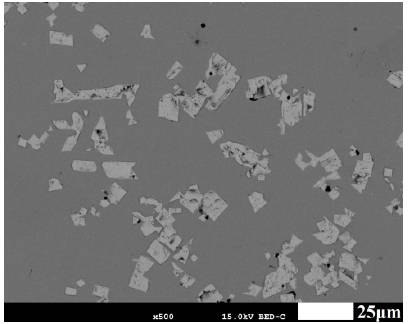
Figure 9. Sample scanning image of alloy with the addition of 4.5% Nb after solution heat treatment; austenitic matrix with niobium carbides, unetched sample.